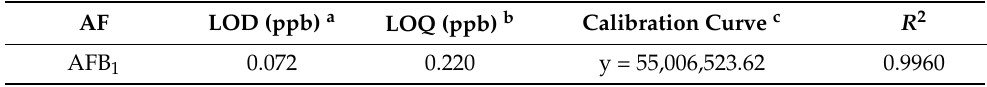
Table 1. Validation of AF determination by HPLC analysis.